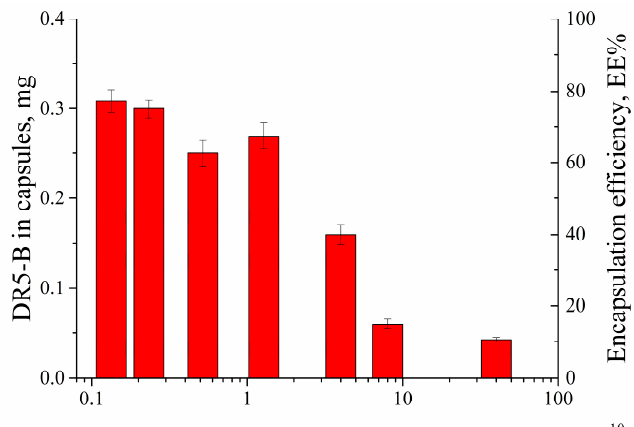
Figure 2. The DR5-B protein loading (mg) into the capsules and encapsulation efficiency (EE%) in the function of the DR5-B/a number of capsules ratio.